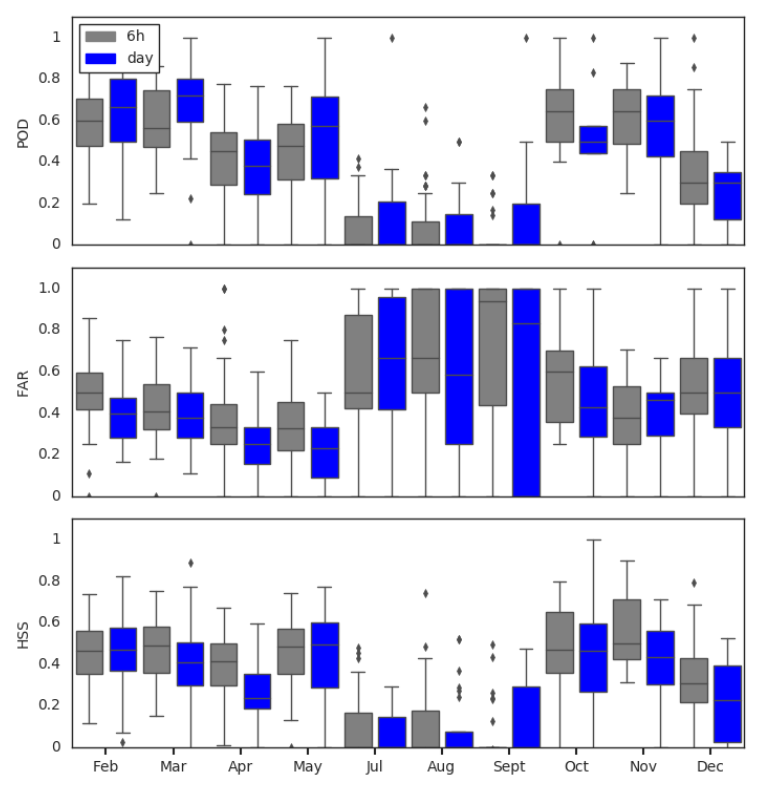
Figure 14. Standard validation scores for the RF classification model (rain area delineation) against gauge stations. The scores are based on the data pairs of 6 h/daily for the time period from February 2017 until the end of 2017. The scores were calculated based on all available pairs for the time period for POD, FAR, and HSS. The gray boxes indicate the results for stations with 6-h resolution and the blue boxes for stations with daily resolution. Boxes show 25th, 50th, and 75th percentiles. Whiskers extend to the most extreme data point between 75th and 25th percentile. Outliers are shown as